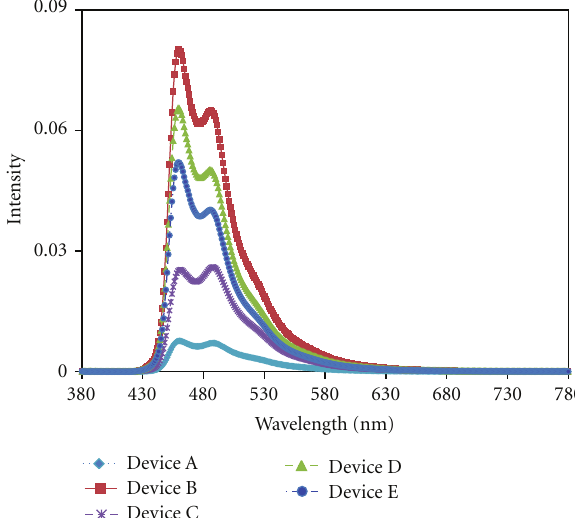
Figure 7: Electroluminescence spectra of the fabricated devices at